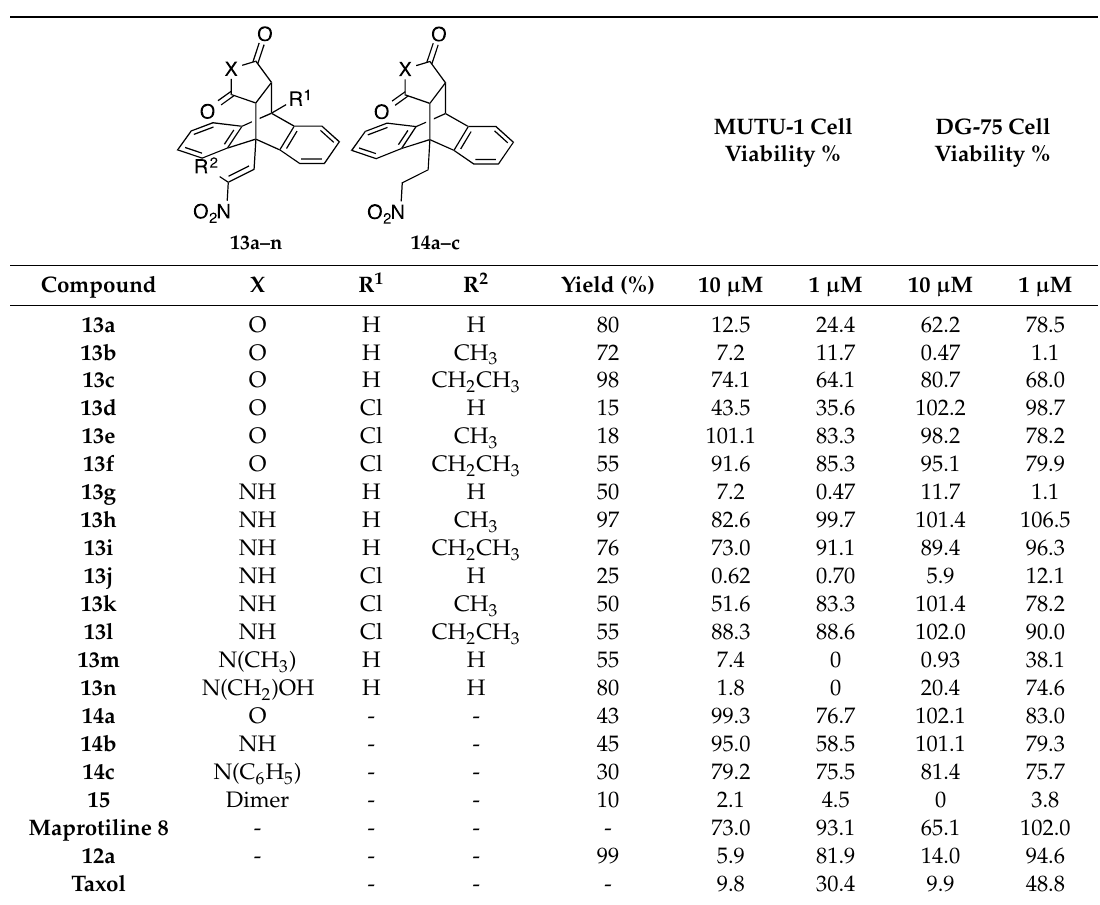
Scheme 3. Synthesis of ethanoanthracene dimer 15 (Series 1, Table 1): Reagents and conditions: ( a ) Toluene, 90 °C, 48 h., (10%). Table 1. Yields and preliminary cell viability data for compounds 13a – n , 15 (Series I) and 14a – c (Series II) in MUTU-1 and DG-75 Burkitt lymphoma cell lines a